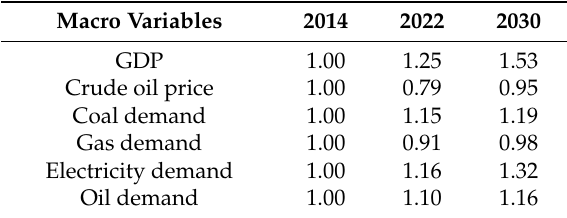
Table 2. Exogenous macro variables for the business-as-usual